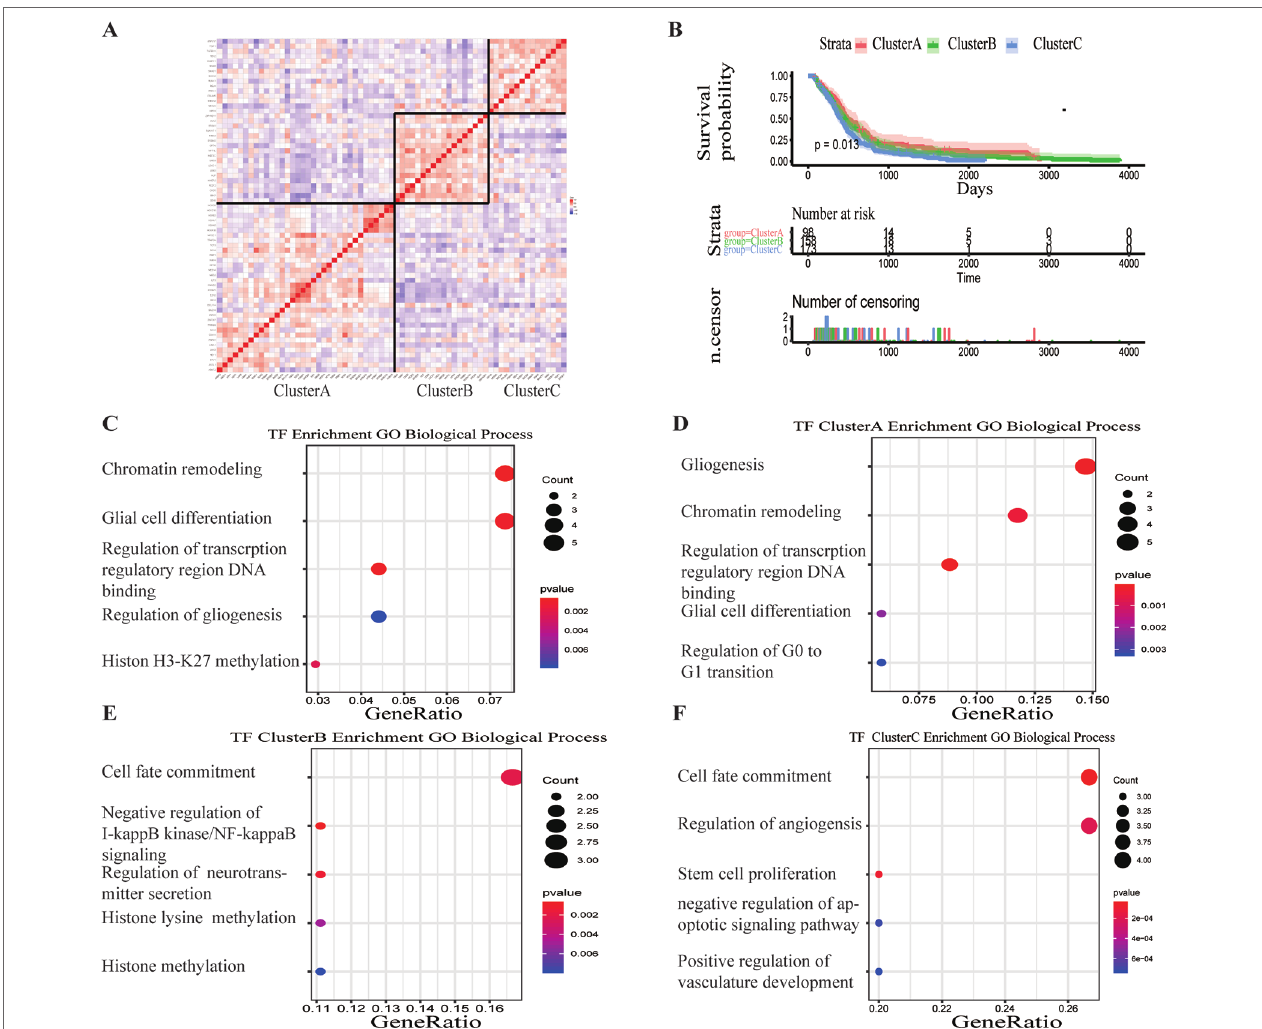
FiGURe 2 | Survival analysis and gene function enrichment of Clusters A–C. (A) Gene expression correlation of Clusters A–C in The Cancer Genome Atlas (TCGA) glioblastoma (GBM) data. (B) Survival analysis of the three groups, Clusters A–C: the patients in Cluster A had the best prognosis, while those in Cluster C had the worst prognosis. (c) Gene Ontology (GO) (biological process) enrichment results of 68 transcription factors. (D – F) GO (biological process) enrichment results of Clusters